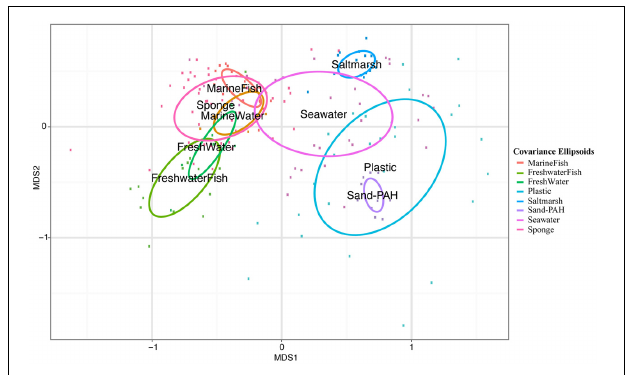
FIGURE 5 | NMDS plot with covariance ellipsoids for both host-associated and environmental samples. Sample names refer to habitat type and VAMPS project listed in Table 1 .